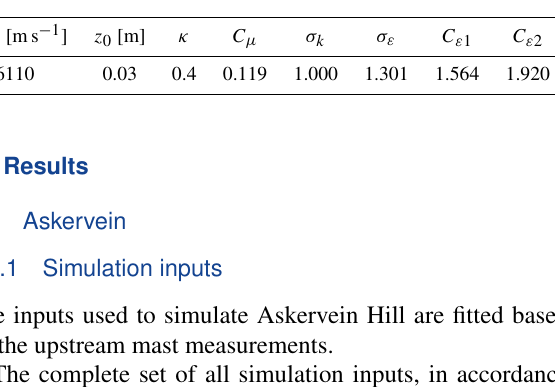
Table 1. Set of atmospheric parameters used for Askervein, as de- scribed in Taylor and Teunissen